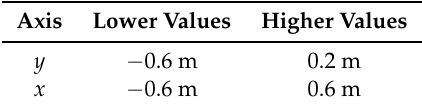
Table 1. Narrow Down Filter